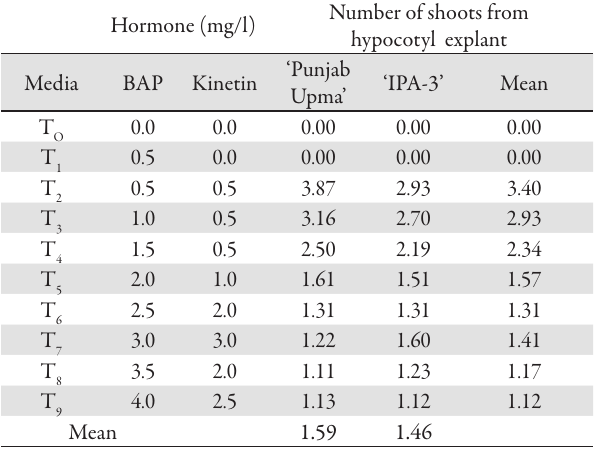
C.D = Genotypes- 0.69, Hormone concentrations 1.56, Hormone x Genotypes-2.20Figures in parenthesis indicates arc since